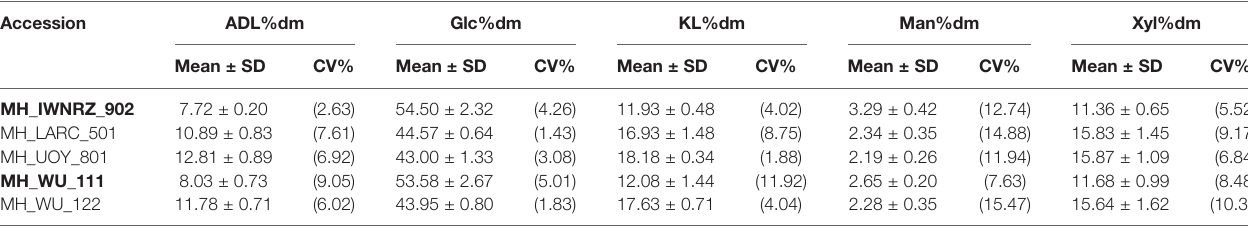
TABLE 4 | Summary statistics of hemp accessions with extreme phenotypes for fi ve cell wall traits.